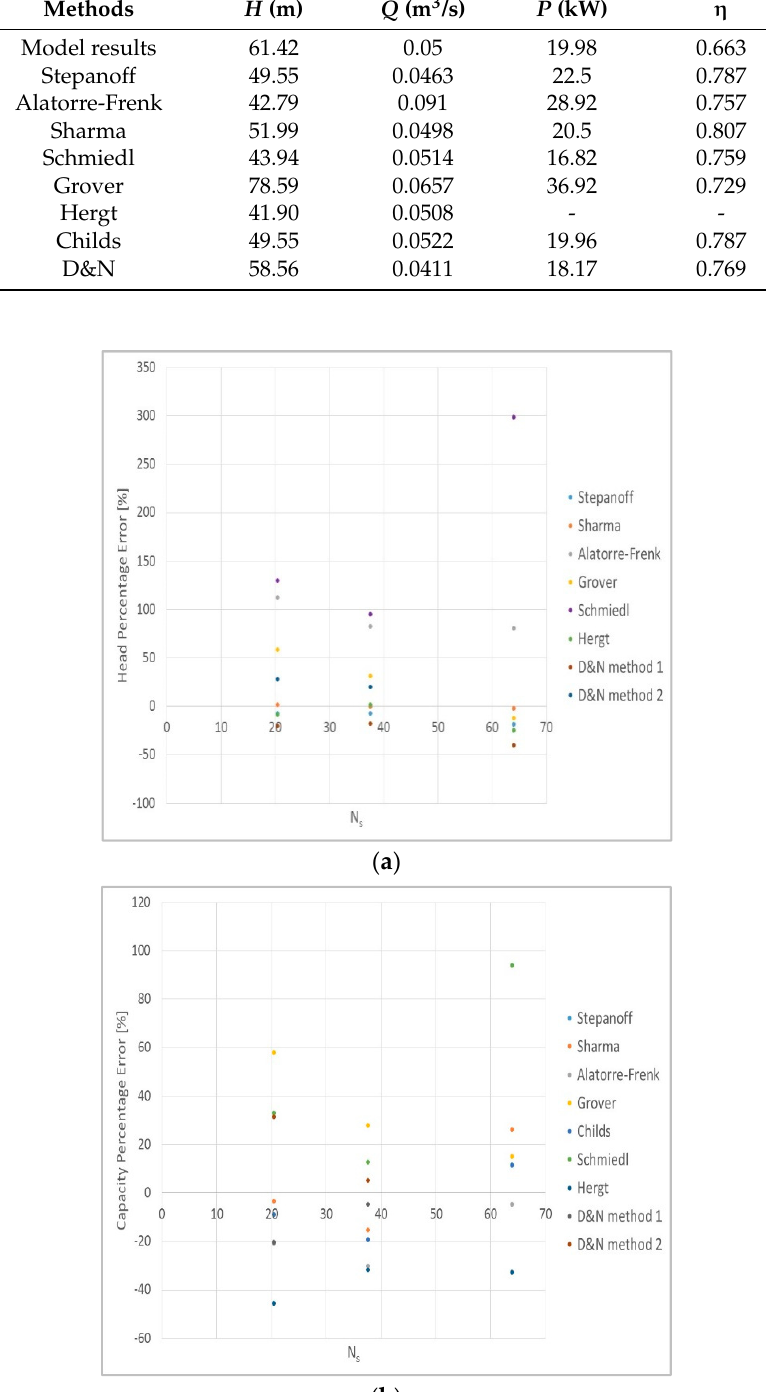
Figure 11. Relative velocity magnitude. 7. Conclusions In this paper a methodology to predict the inverse characteristic of a centrifugal pump has been presented. This methodology is based on the results of a three-dimensional simulation model built with a commercial CFD code. Three industrial pumps have been analyzed, with different specific speeds. First, the simulation models have been validated with data supplied by the pump manufacturers. Then the results of an experimental campaign have been used to validate a model simulating the pump working in reverse conditions.